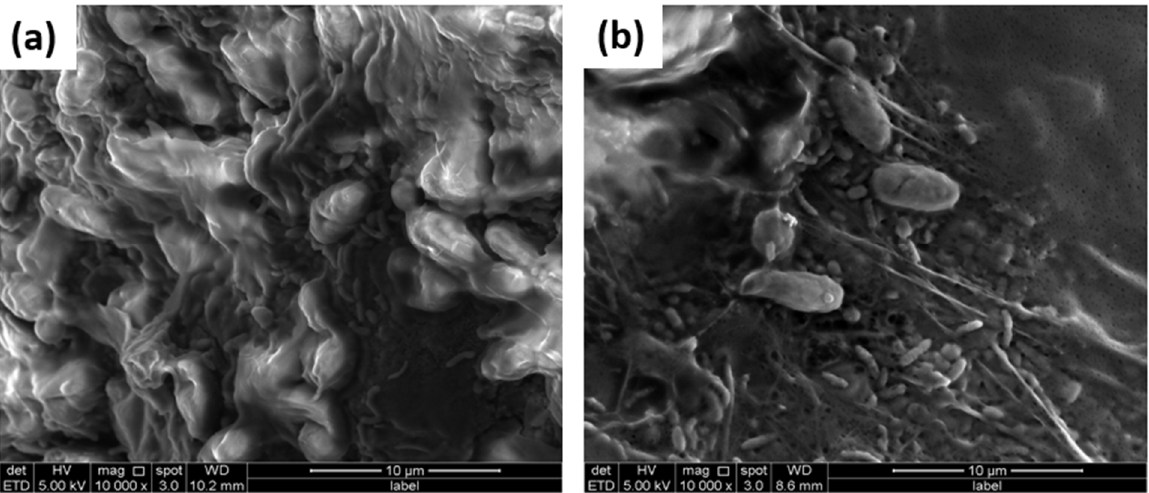
Figure 7. SEM images of ( a) treated anode and ( b ) treated cathode on day 60.